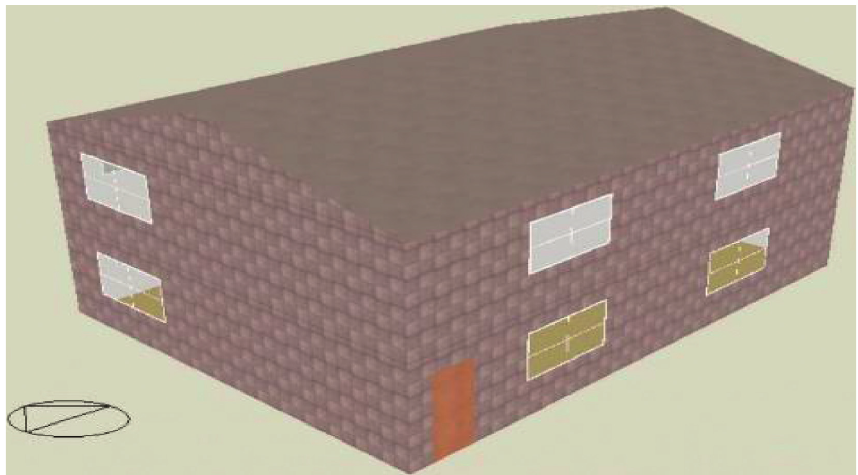
Figure 3: Model of the two-storey reference residential building.